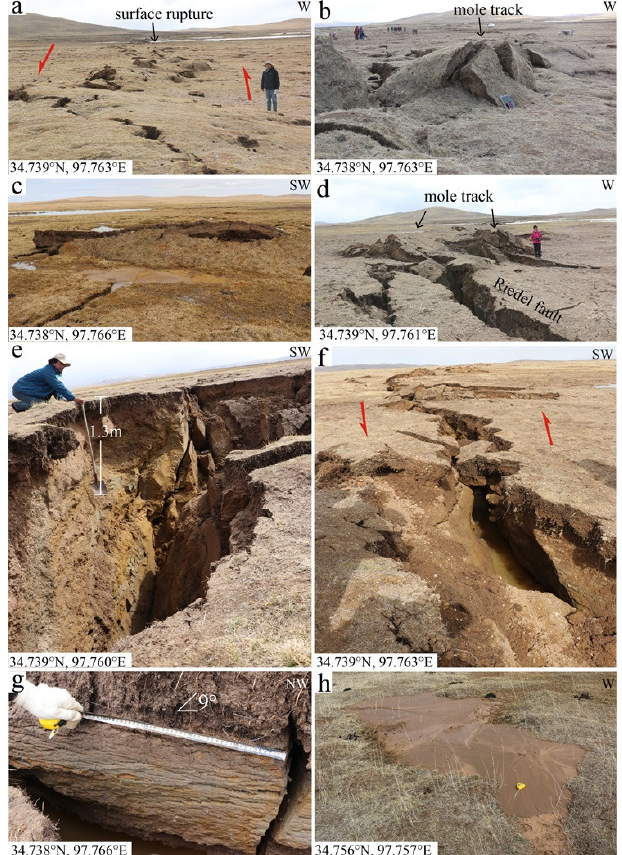
Figure 4. Representative field photographs of the rupture trace on the South Eling Lake segment: ( a ) continuous up-bulged mole track on the folded rupture; ( b ) mole tracks developed on a folded section; ( c ) typical pressure ridge; ( d ) up-bulged mole track bounded by rotated Ridel faults; ( e ) extensional crack; ( f ) continuous distributed extensional crack along the surface rupture; ( g ) fault slickensides; ( h ) sand liquefaction.